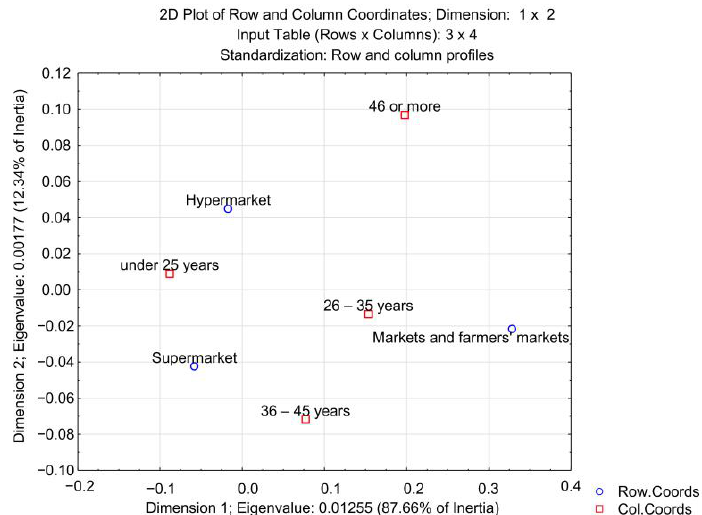
Figure 9. Place of purchase & gender; Source: authors.